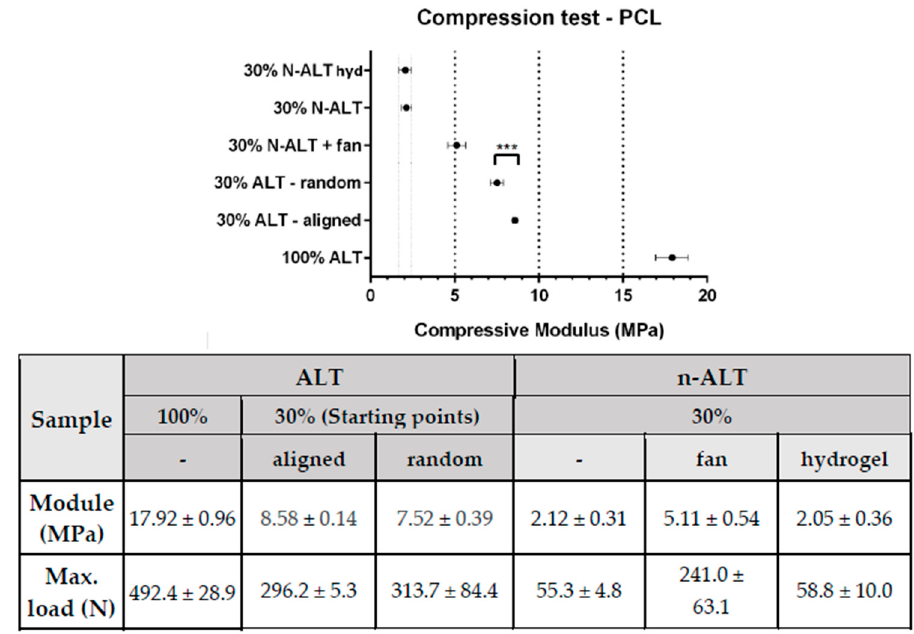
Figure 6. Summary of the compression test results (± standard deviation) with a comparative graph at the top. (n = 10, mean ± SD, ***p <0.0002). All, but the first two (w and w/o hydrogel), represent significative difference with p < 0.0001.